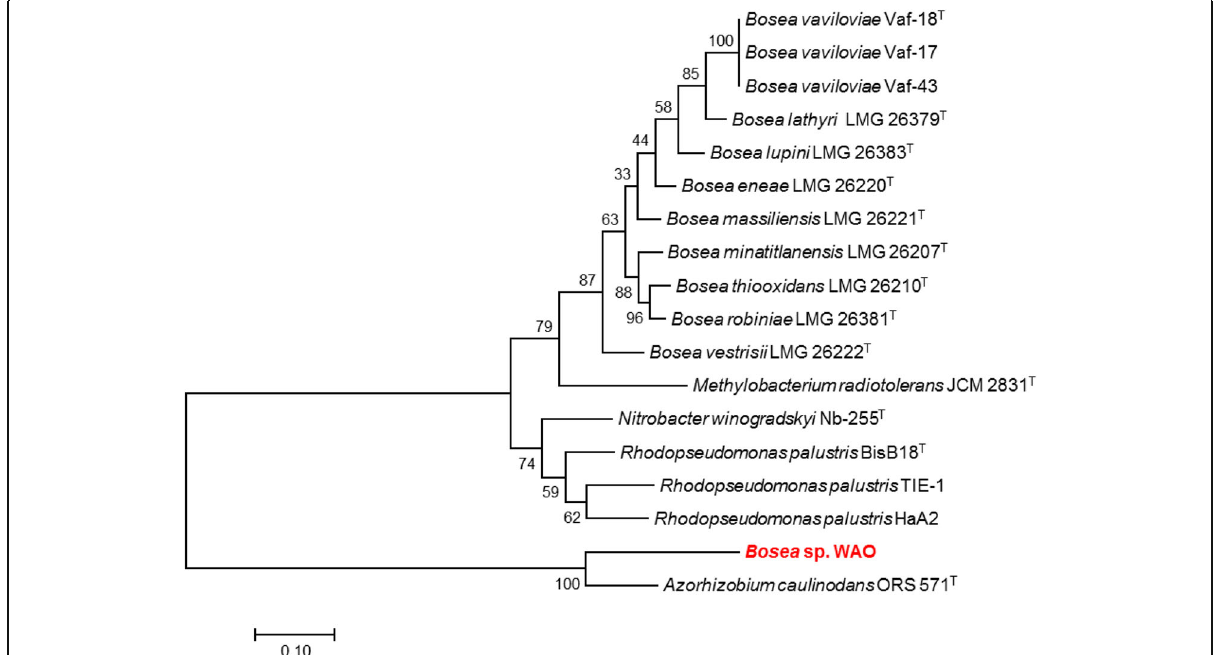
Fig. 5 Molecular Phylogenetic analysis by Maximum Likelihood method of gyrB gene. The evolutionary history was inferred by using the Maximum Likelihood method based on the Tamura-Nei model [19]. The tree with the highest log likelihood ( − 4279.1901) is shown. The percentage of trees in which the associated taxa clustered together is shown next to the branches. Initial tree(s) for the heuristic search were obtained automatically by applying Neighbor-Join and BioNJ algorithms to a matrix of pairwise distances estimated using the Maximum Composite Likelihood (MCL) approach, and then selecting the topology with superior log likelihood value. The tree is drawn to scale, with branch lengths measured in the number of substitutions per site. The analysis involved 18 nucleotide sequences. Codon positions included were 1st+2nd+3rd+Noncoding. All positions containing gaps and missing data were eliminated. There were a total of 508 positions in the final dataset. Evolutionary analyses were conducted in